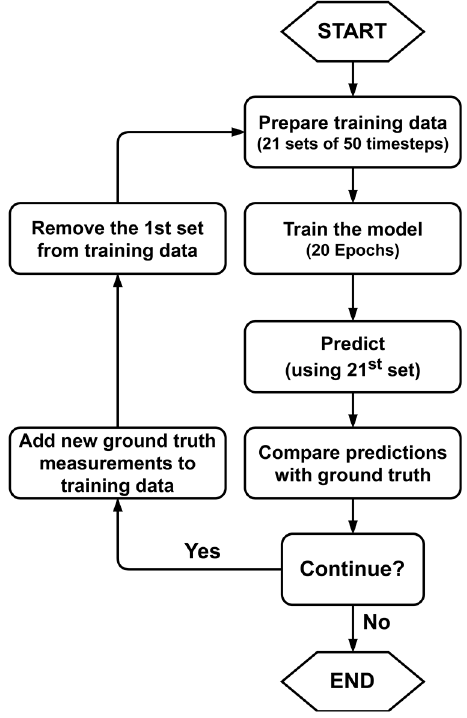
Figure 12. Training and prediction method.